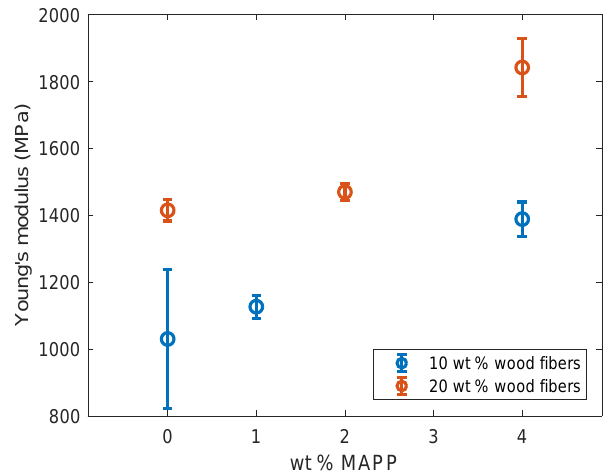
Figure 6. Young’s modulus as function of MAPP percentage for 10 wt % wood fibres and 20 wt % wood fibres.